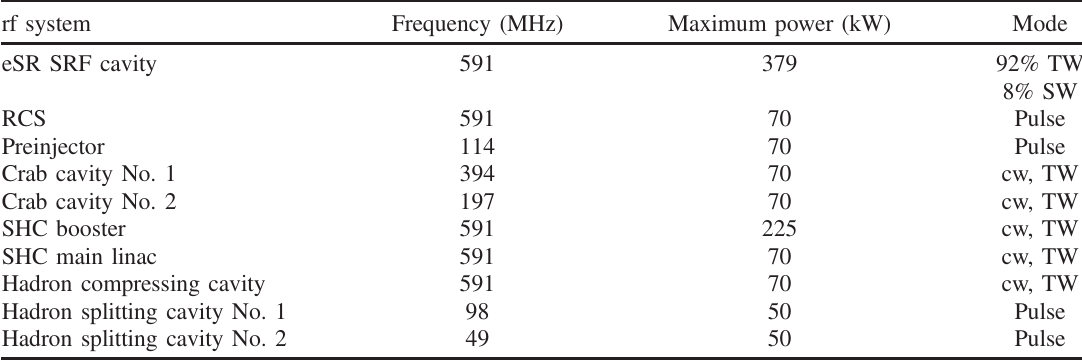
TABLE I. EIC FPC power coupler needs.